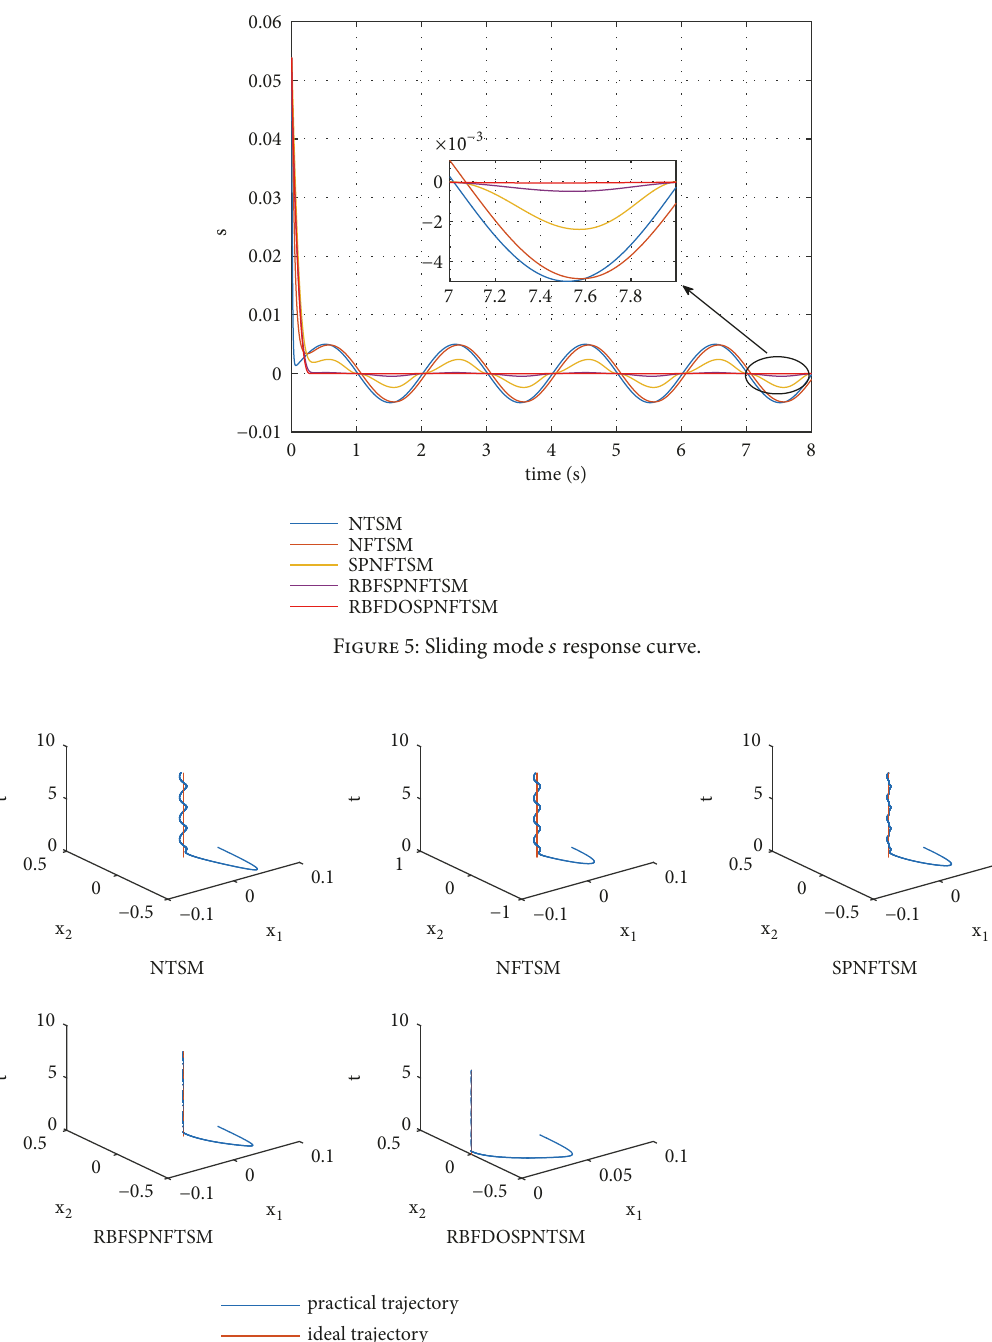
Figure 6: System phase trajectory three-dimensional